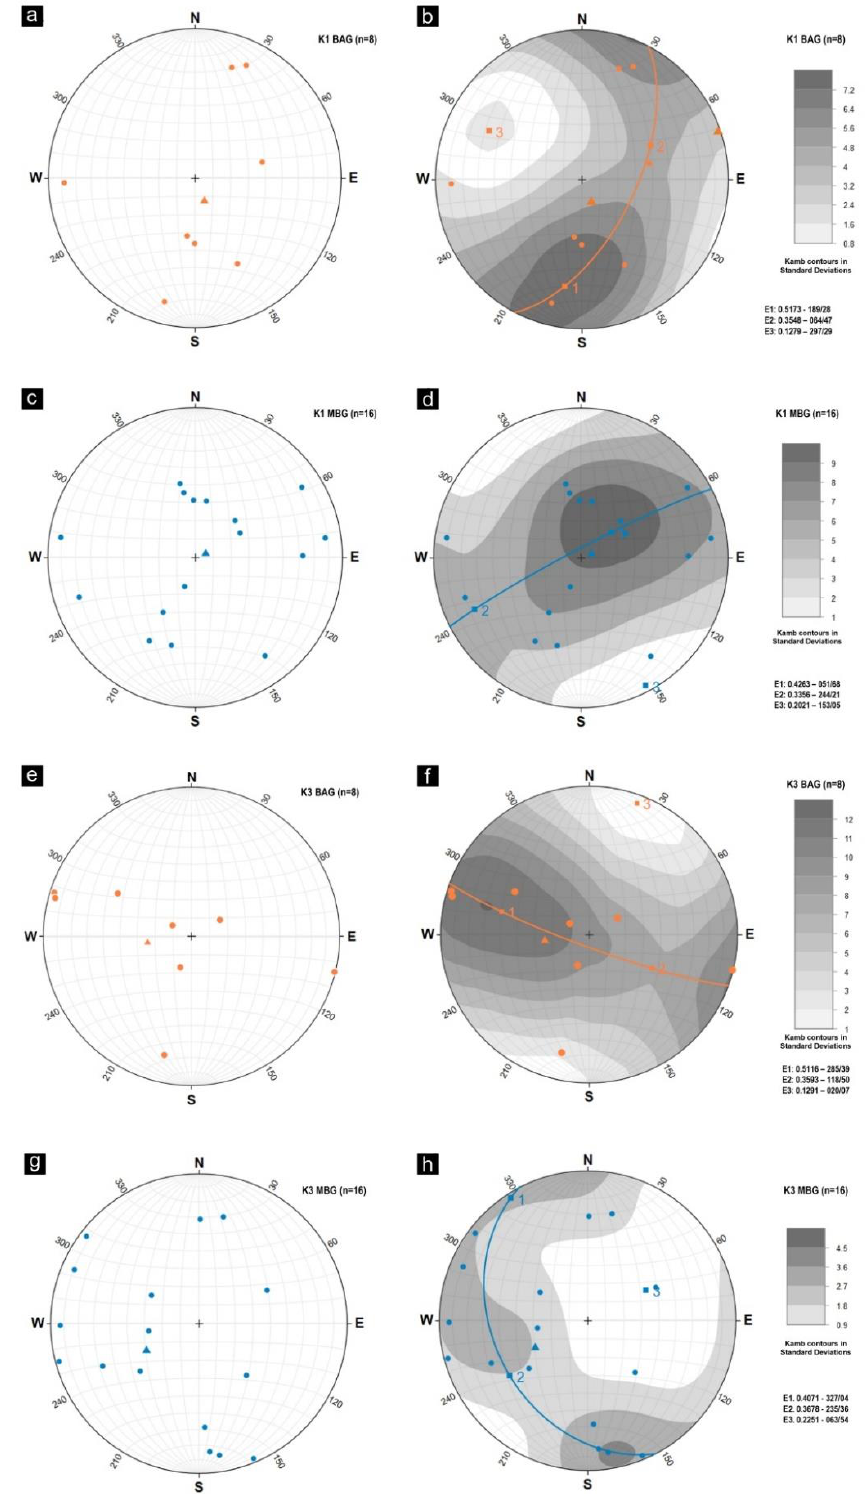
Figure 7. Lower hemisphere, equal-area projections of the AMS orientations for studied samples. K 1 ( a – d ) poles and contouring of magnetic lineation for BAG ( a , b ), MBG ( c , d ) and K 3 ( e – h ) poles and contouring of magnetic foliation for BAG ( e , f ) and MBG ( g , h ). Eigenvectors of the Bingham analysis (E1, E2, E3) are also displayed for both modulus and orientation (trend/plunge); n is the number of considered AMS samples (each dot in the stereonet is the mean of 3–7 individual core measurements).